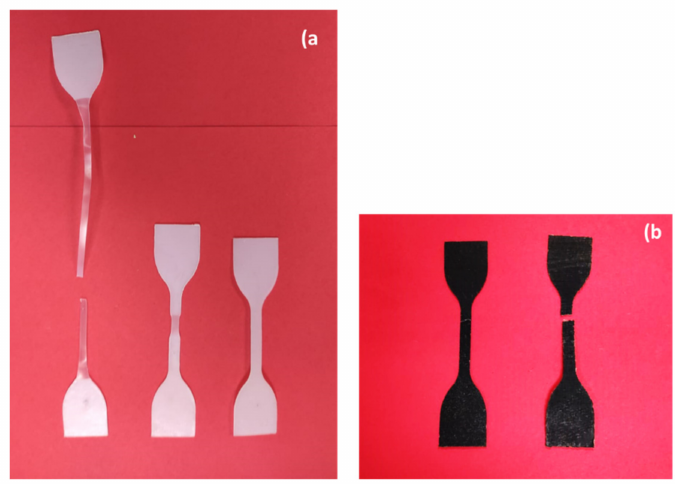
Figure 6. Comparison of tensile specimens: ( a ) PA12, ( b )